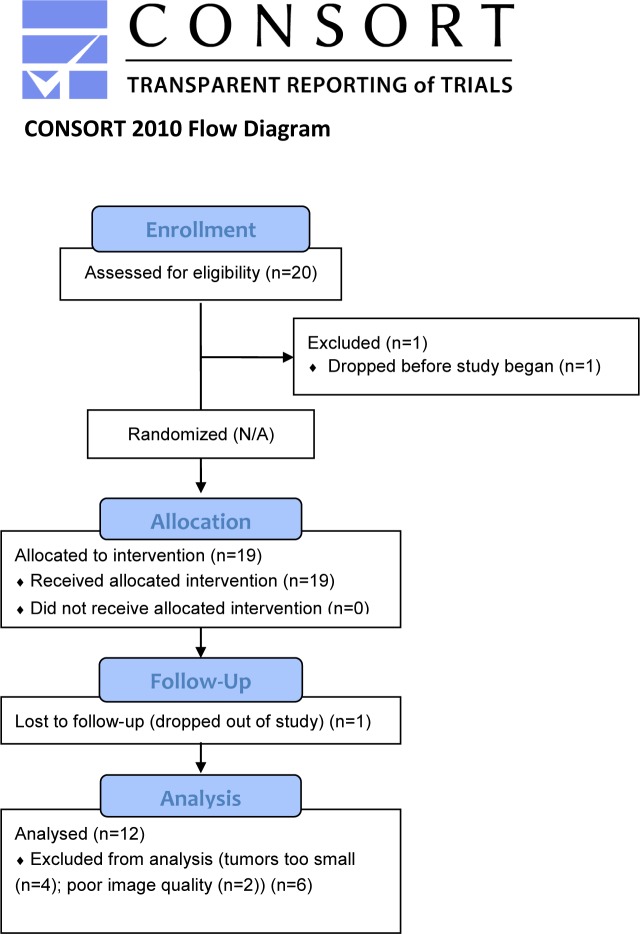
A CONsolidated Standards of Reporting Trials (CONSORT) flow diagram of the overall study patient population recruitment and disposition over the course of study.